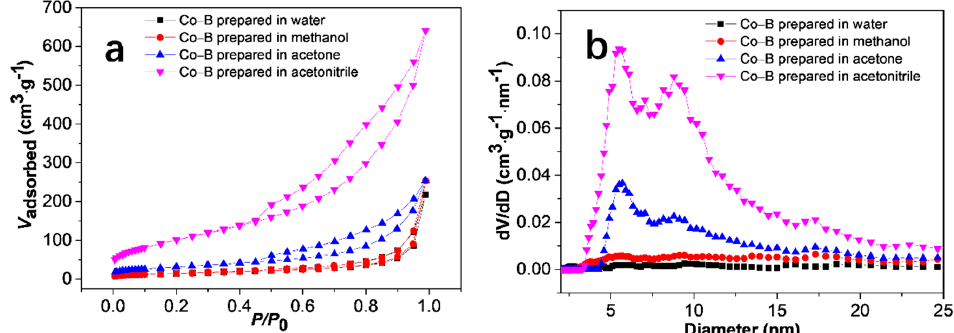
Figure 5. ( a ) Nitrogen adsorption-desorption isotherms of Co–B powders prepared using water,